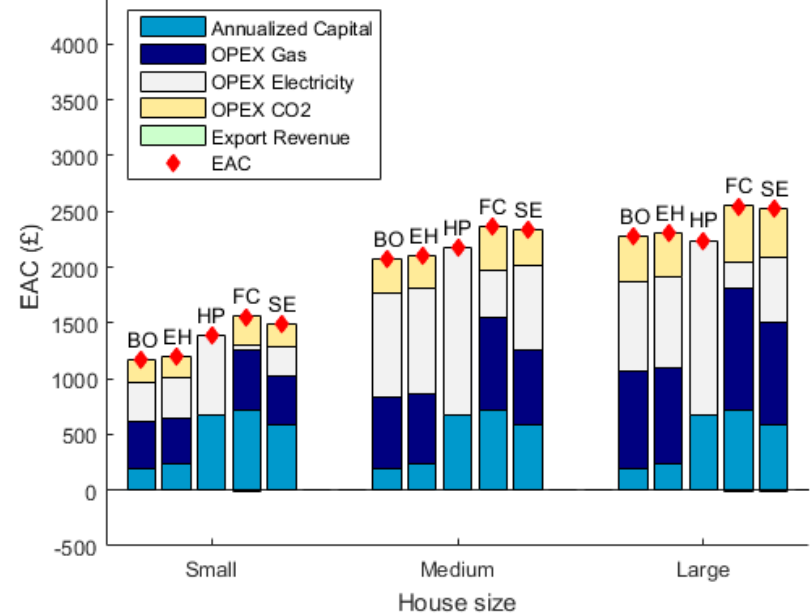
Figure 5. Equivalent Annual Costs in the short run electricity price regime (BO—Boiler, EH—Electric heater, HP—Heat pump, FC—Fuel cell micro CHP, SE—Stirling engine micro CHP).